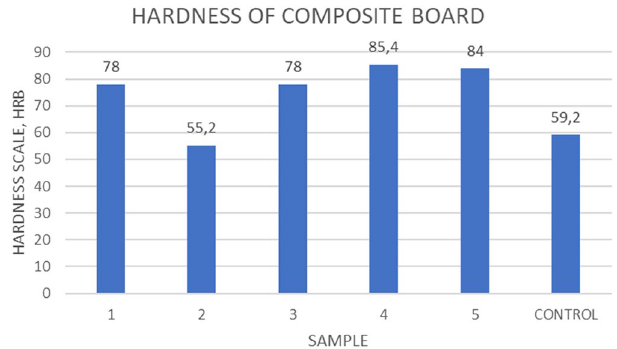
Figure 7. Effect of fibre content and treatment on Rockwell hardness.